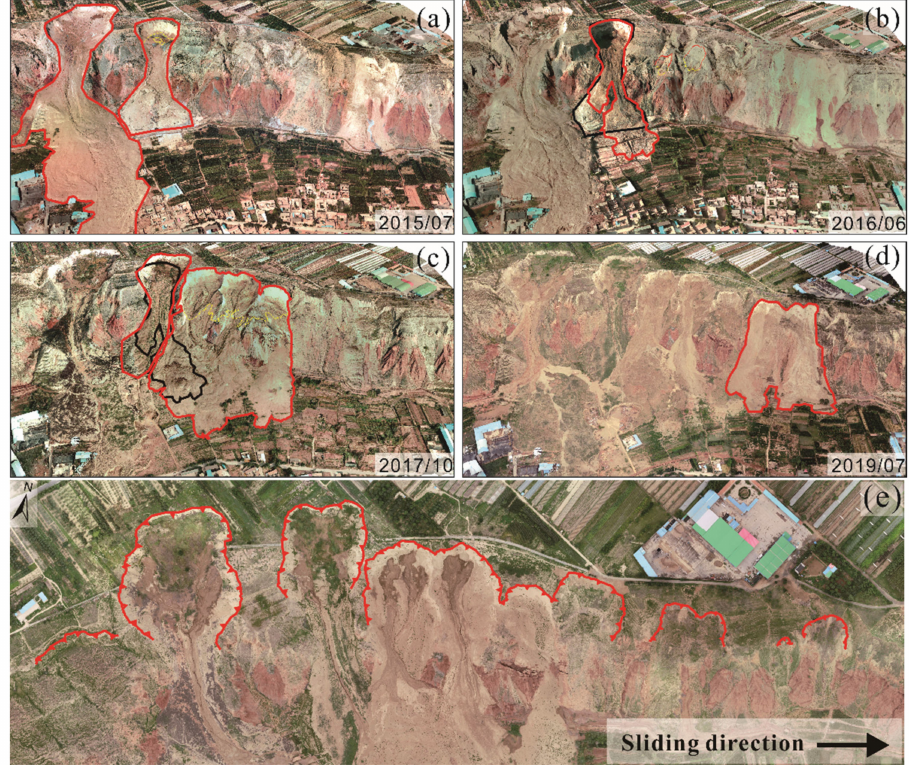
Figure 4. Reconstructions of Dangchuan from 2015 to 2019: ( a – e ) three-dimensional reconstructions. Slidings extracted from a digital surface model (DSM) and orthophoto